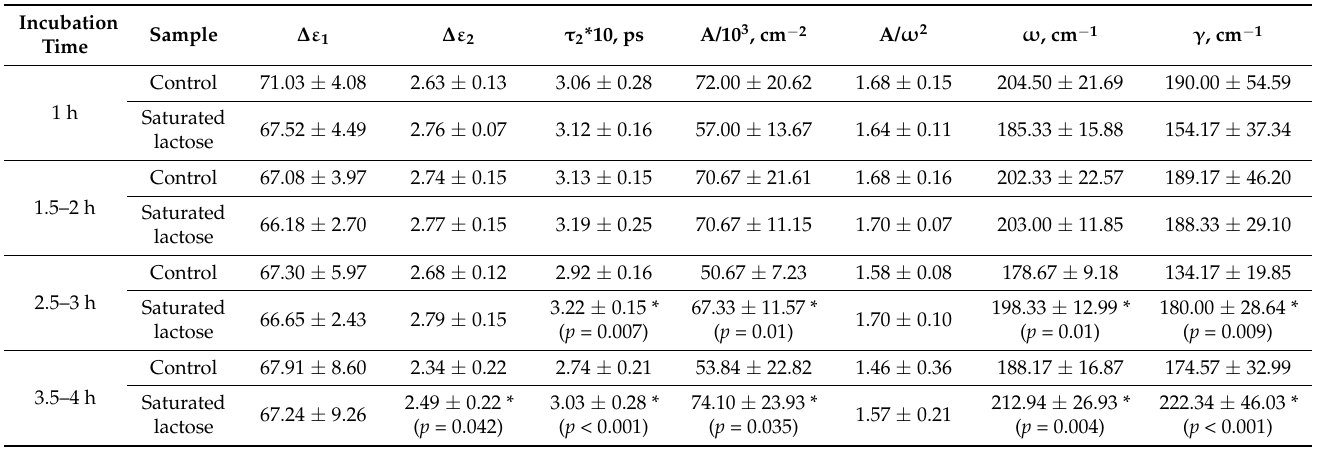
Table 1. Results of terahertz time-domain spectroscopy data analysis: model calculated parameter values (5). The data are presented as mean ±